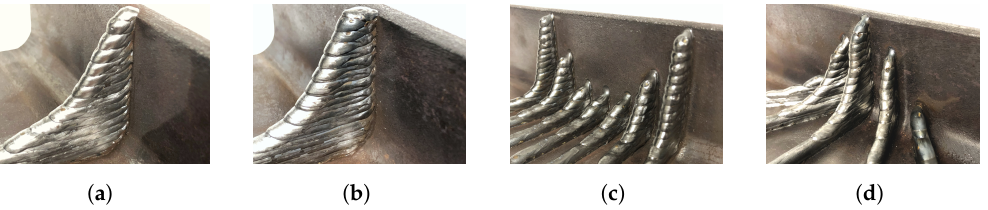
Figure 25. Detailed view on WAAM stiffeners in the area of the flange connection: ( a ) IIa; ( b ) IIIa; ( c ) IIb; ( d ) IIIb.